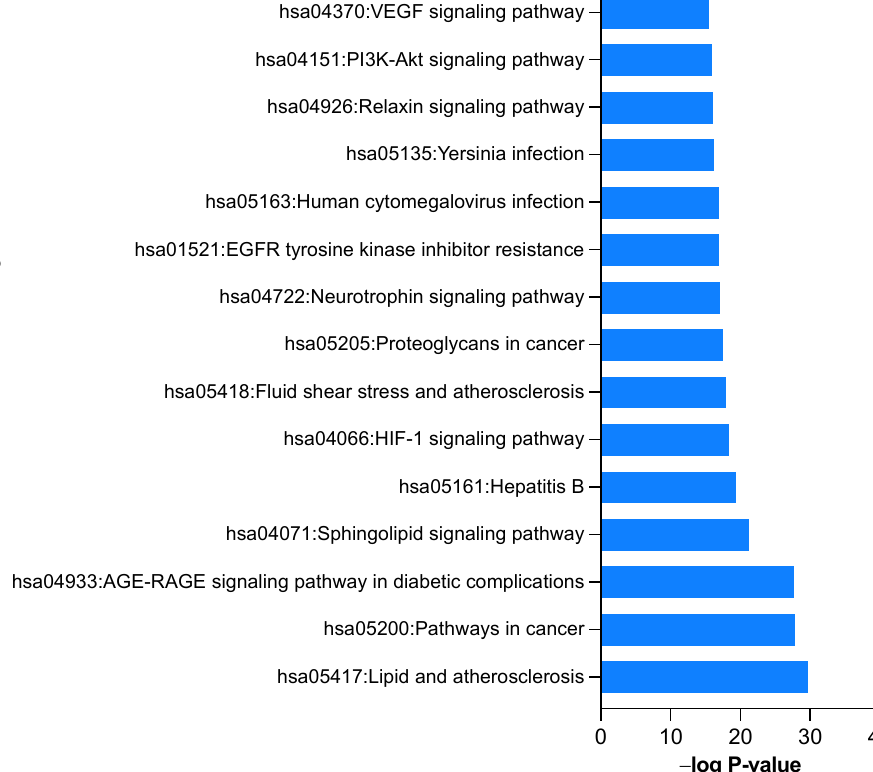
Figure 7. Kyoto Encyclopedia of Genes and Genomes (KEGG) pathway enrichment analyses.